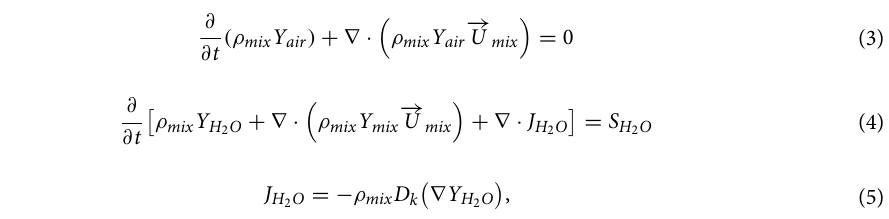
are the species mass fraction, and φ air , φ H where Y air , Y H 2 O respectively. With the Eulerian description, the continuity equations of dry air and water vapor are solved separately to obtain the transport characteristics of the ambient airflow field: